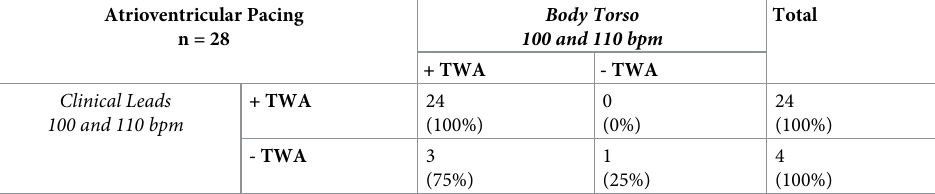
Table 3. Effect of lead configuration on clinically +TWA during atrioventricular